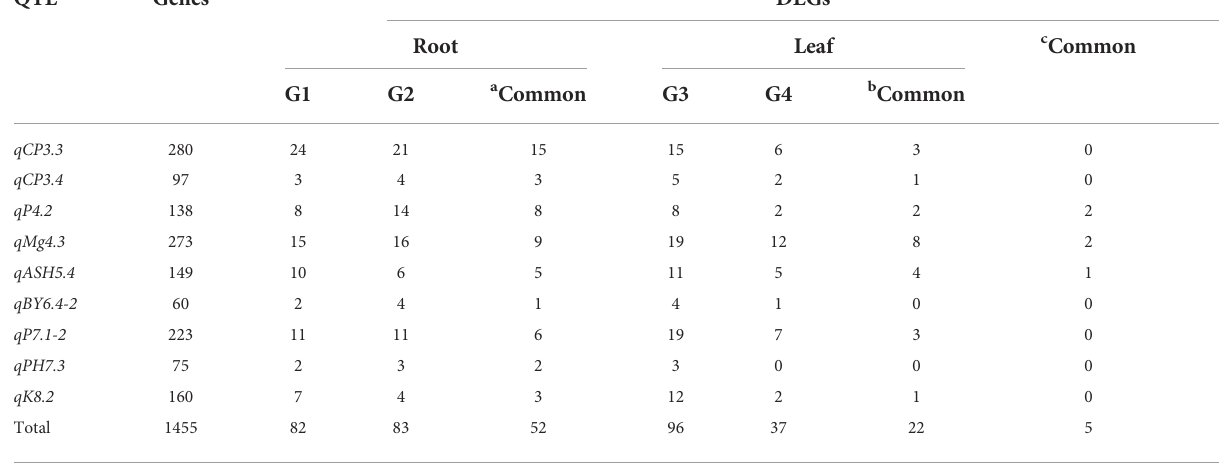
TABLE 2 Number of genes, DEGs within nine main QTL (PVE > 10%)